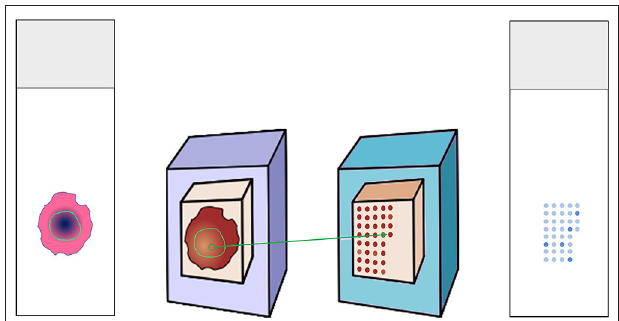
FIGURE 1 | Construction of tissue microarray. Donor H&E slides were annotated for the tumor region. The matching donor blocks were identified and annotated as well. Three cores from the region of interest were punched out and embedded in the recipient paraffin block. The recipient block could then serve for multiple analyses, e.g., immunohistochemical stainings.